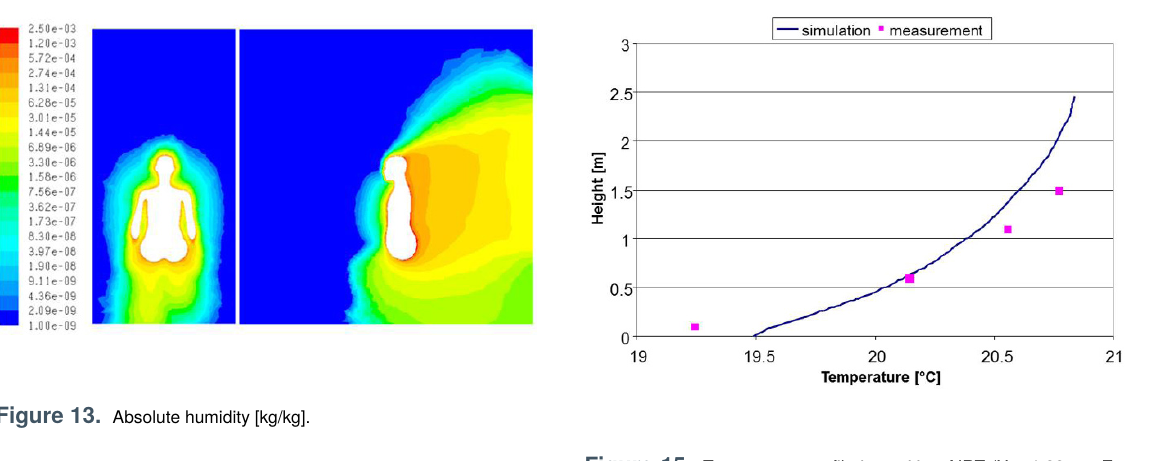
Figure 15. Temperature profile in position AIRT (X = 1.22 m , Z = 1.1 m ). Measurement data taken at heights Y = 0.1, 0.6, 1.1, 1.5 m.